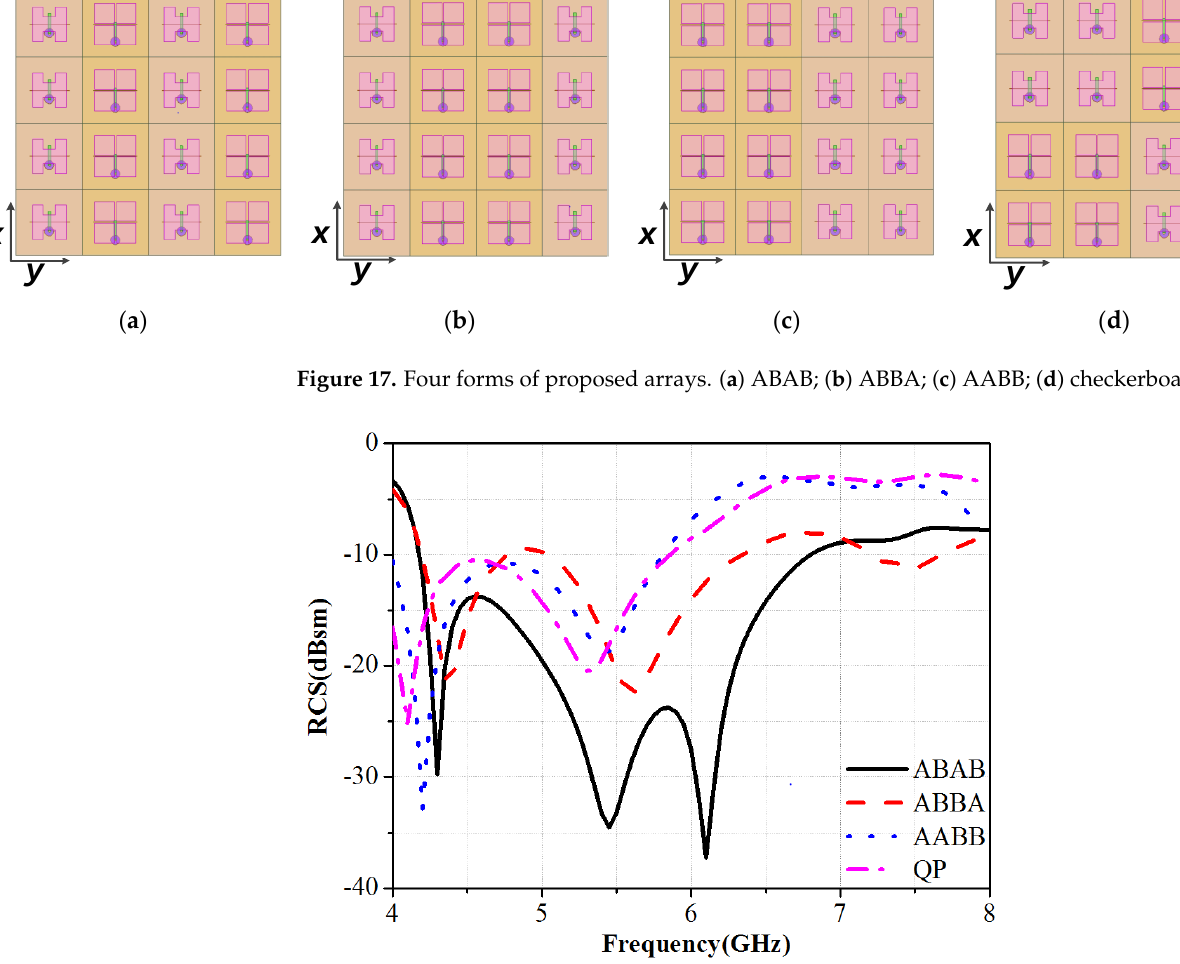
Figure 19. Geometry of reference array.